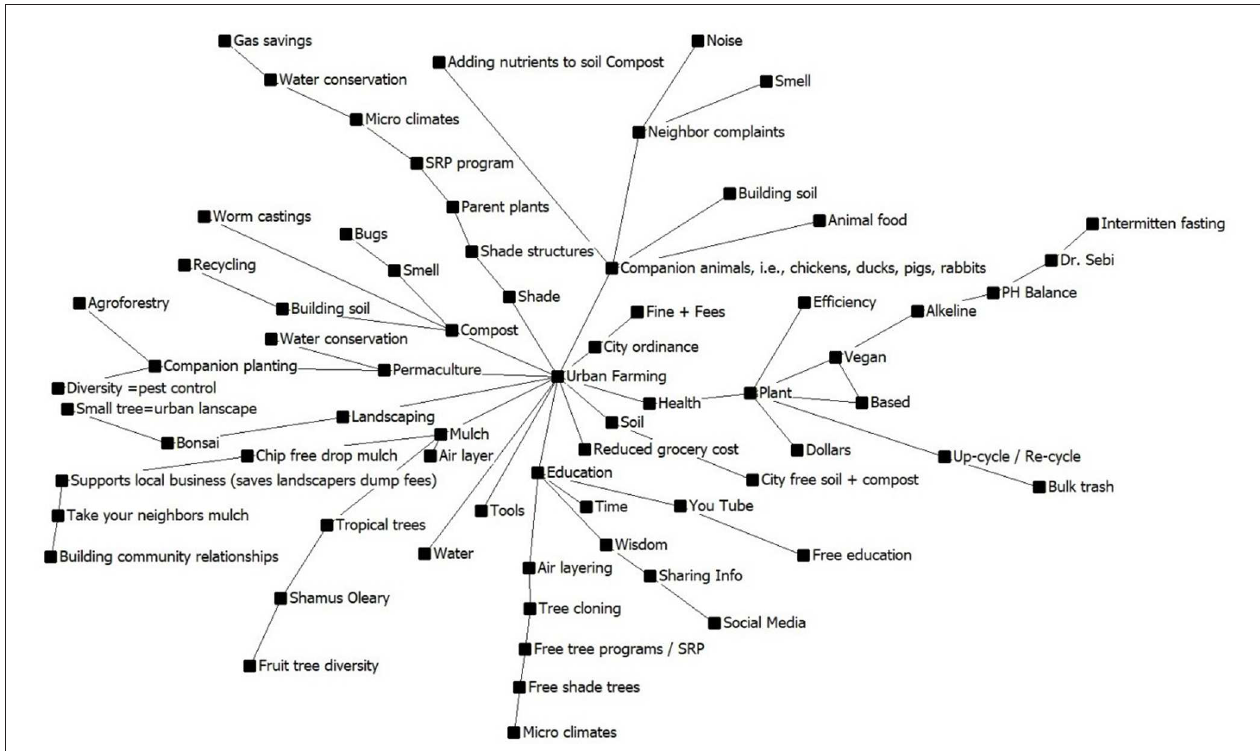
FIGURE 7 | Example of an individual network 5 (location 1, ID